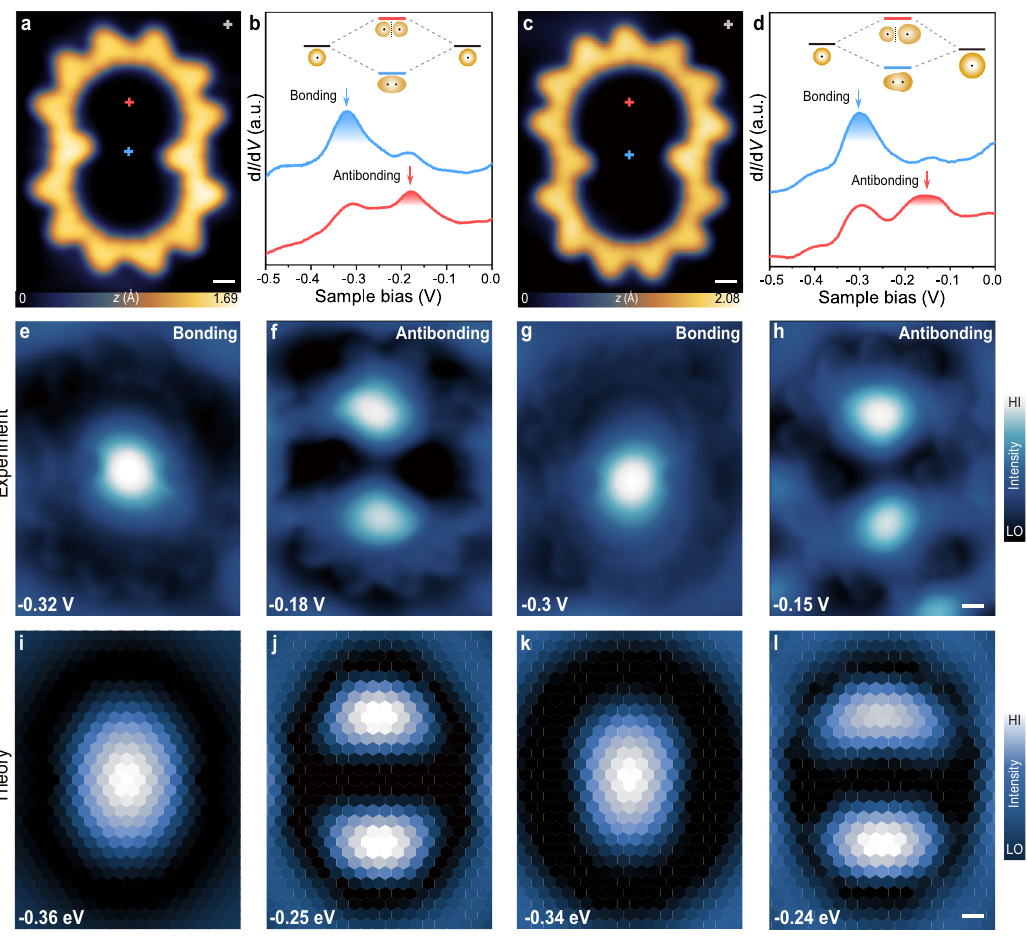
Fig. 4 Characterization of coupled quantum resonance states in COS-OQCs. a STM image of a symmetric COS-OQC ( V = − 0.32 V, I = 1.5 nA). b Point d I /d V spectra acquired over different sites inside a symmetric COS-OQC and Au(111) substrate. d I /d V curves taken at the neck (blue curve) and 1.23 nm away from the neck of symmetric COS-OQC (red curve). c STM image of an asymmetric COS-OQC ( V = − 0.3 V, I = 1.5 nA). d Point d I /d V spectra acquired over different sites inside an asymmetric COS-OQC and Au(111) substrate. d I /d V curves taken at the neck (blue curve) and 1.4 nm away from the neck of an asymmetric COS-OQC (red curve). e , f Constant-current d I /d V maps recorded at different energy positions over a symmetric COS-OQC ( I = 1 nA for e , f ). Panels e , f refer to the bonding ( − 0.32 V) and antibonding ( − 0.18 V) states, respectively. g , h Constant-current d I /d V maps recorded at different energy positions over an asymmentric COS-OQC ( I = 1 nA for g , h ). Panels g , h refer to the bonding ( − 0.3 V) and antibonding ( − 0.15 V) states, respectively. i , j Simulated spectral function maps of a symmetric COS-OQC acquired at different energy positions corresponding to bonding ( − 0.36 eV) and antibonding states ( − 0.25 eV), respectively. k , l Simulated spectral function maps of an asymmetric COS-OQC acquired at different energy positions corresponding to bonding ( − 0.34 eV) and antibonding states ( − 0.24eV), respectively. Scale bar: 5 Å